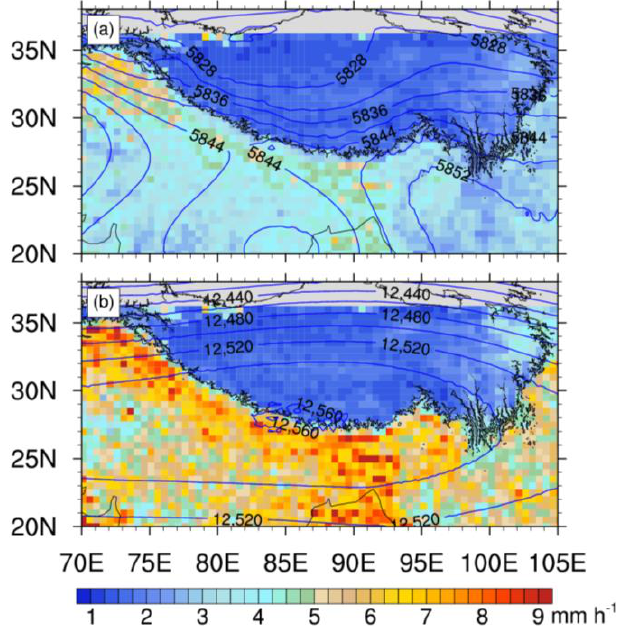
Figure 3. The distribution of mean rain rate of ( a ) total precipitation and ( b ) DCP in summer over the QTP and its southern regions based on observations of TRMM PR from 1998 to 2012. The blue lines were drawn for the mean geopotential height at ( a ) 500 hPa and ( b ) 200 hPa, calculated by using ERA5 monthly reanalysis data.